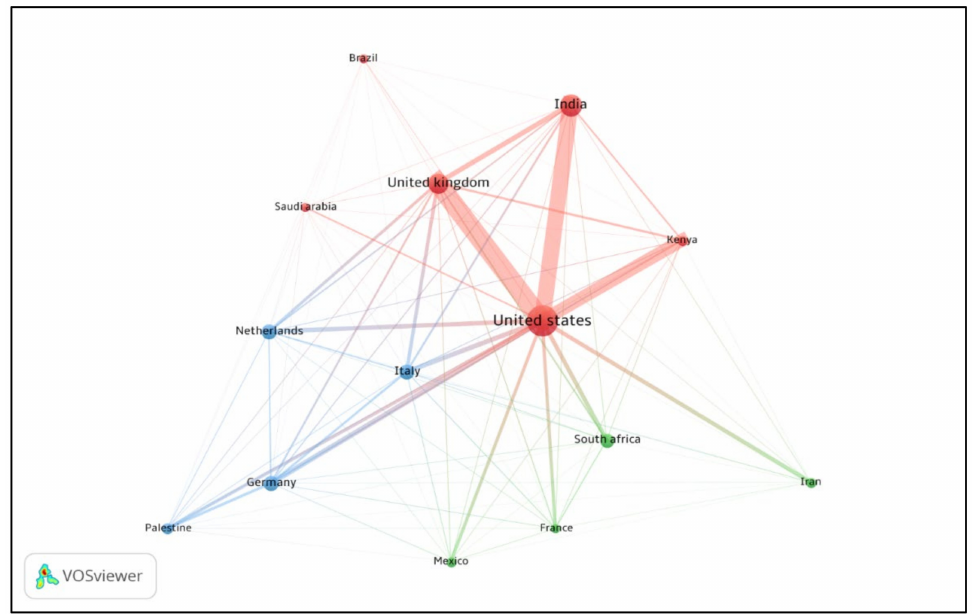
Figure 7. Bibliographical coupling among countries using network visualization maps. Five doc- uments were specified as a threshold for each country. Fourteen countries met the set threshold. The overall strength of bibliographical coupling links was estimated for each country that met the threshold. The selected countries were the ones that acquired the highest total link strength.